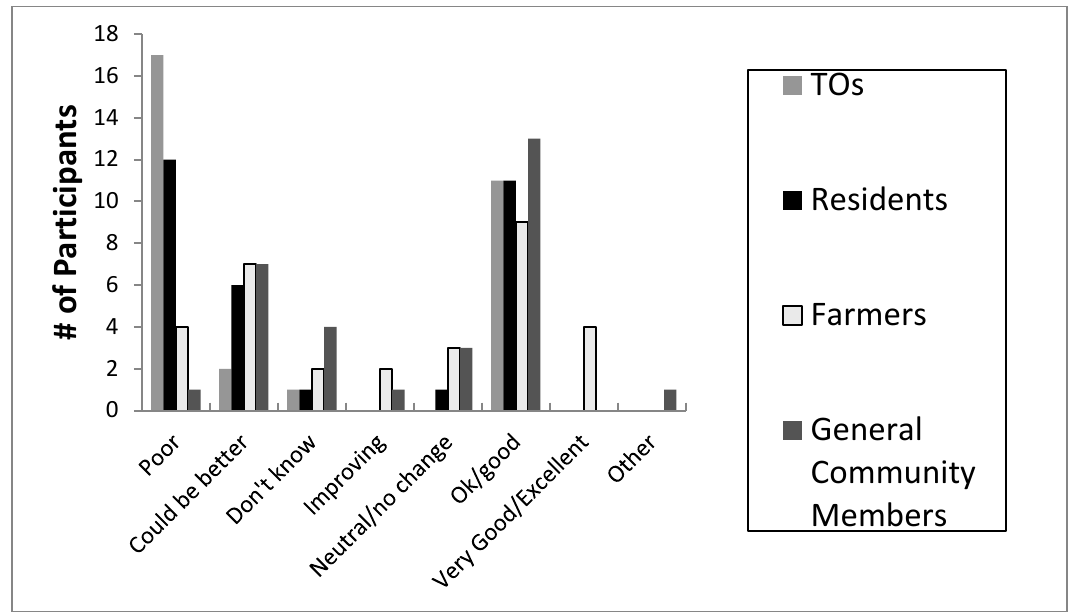
Figure A6. Perceptions of basin water quality conditions by stakeholder group. Water 2020 , 12 , x FOR PEER REVIEW